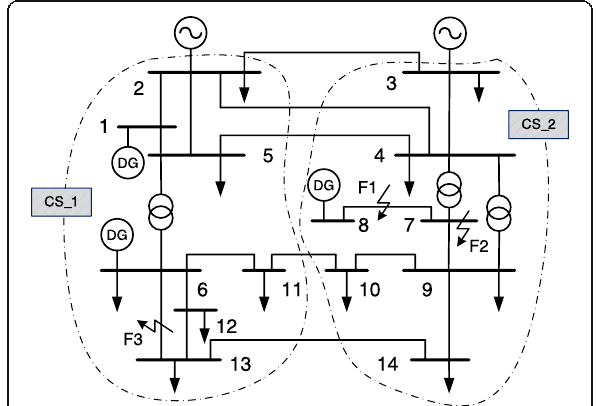
Fig. 4 IEEE 14-node system